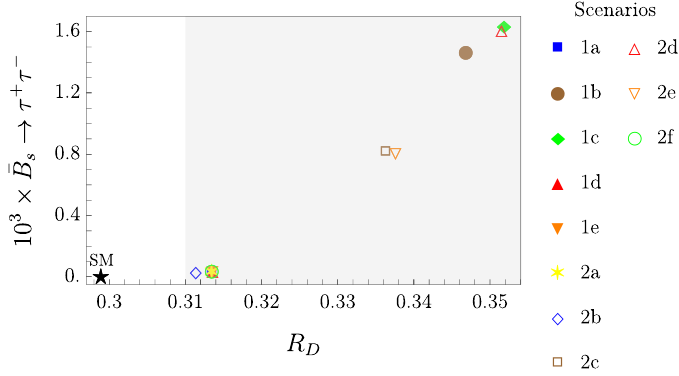
Figure 1 . Correlation between (cid:22) B s ! (cid:28) + (cid:28) (cid:0) and R D for all the 11 scenarios listed in table 4. The grey band represents the 1 (cid:27) region for R D (see table 6 for the numerical values used in the